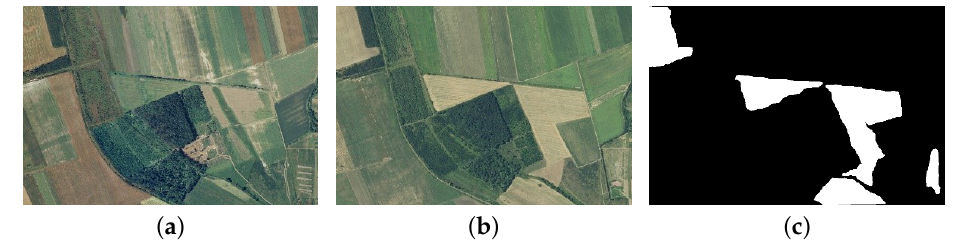
Figure 8. Tiszadob of ACD. ( a ) Pre-change. ( b ) Post-change. ( c ) ground truth map.